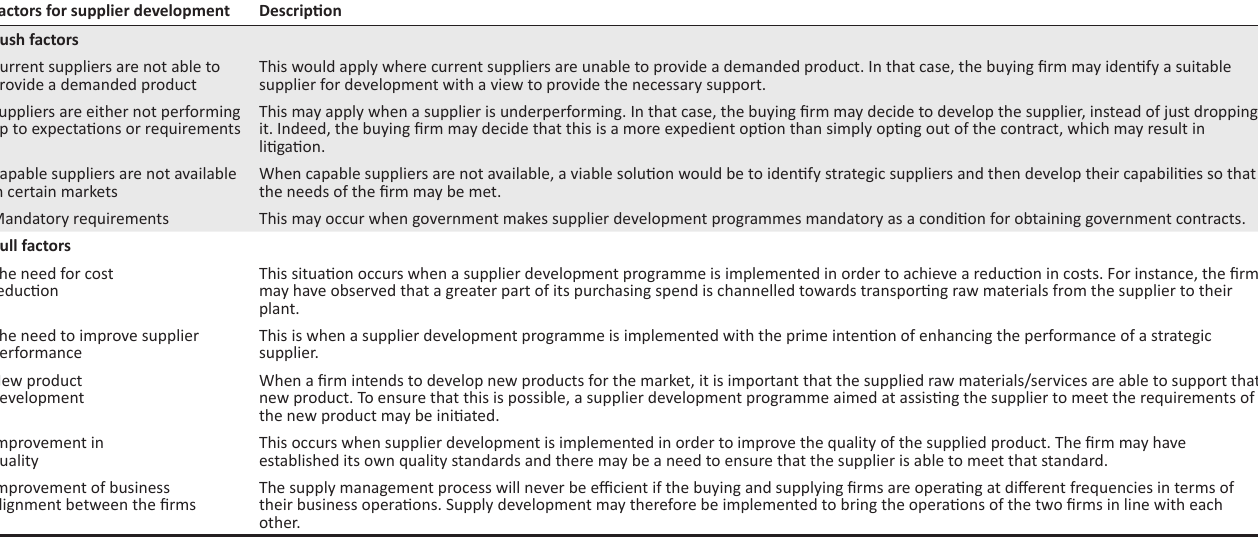
TABLE 1: Push and pull factors for supplier